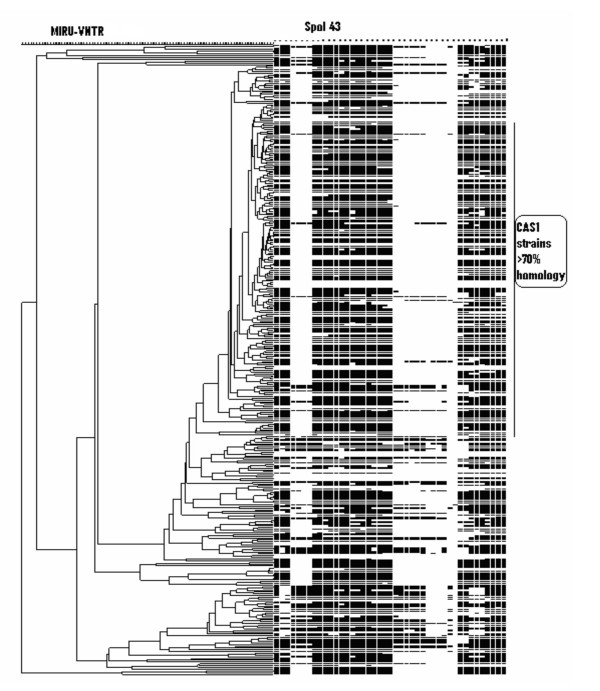
MIRU-VNTR typing of Mycobacterium tuberculosis from Pakistan. Three hundred and sixty seven strains were typed and a cluster analysis was carried out using Bionumerics software using the unweighted pair group method. The 178 CAS1 strains studied showed an overall homology of >70%. No MIRU clusters were observed between any of the 189 'unique' strains studied.